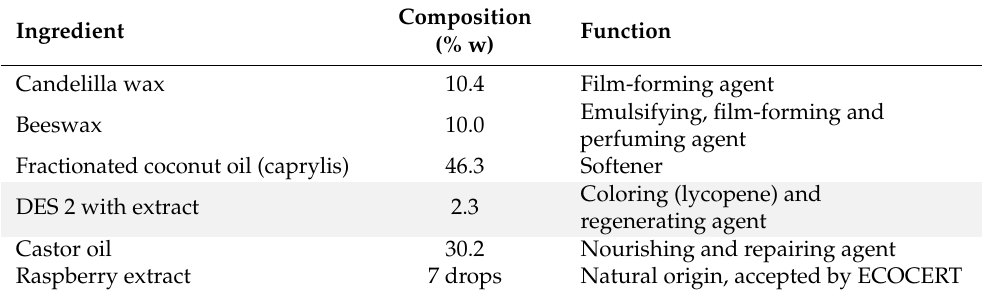
Table 10. Composition of lip balm.